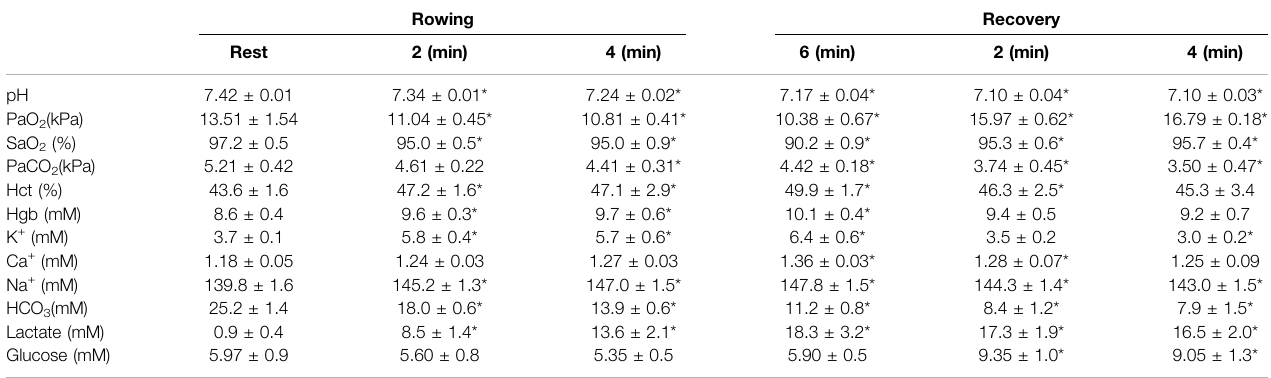
TABLE 2 | Blood variables during and after maximal ergometer rowing with infusion of isotonic saline. Rowing Recovery Rest